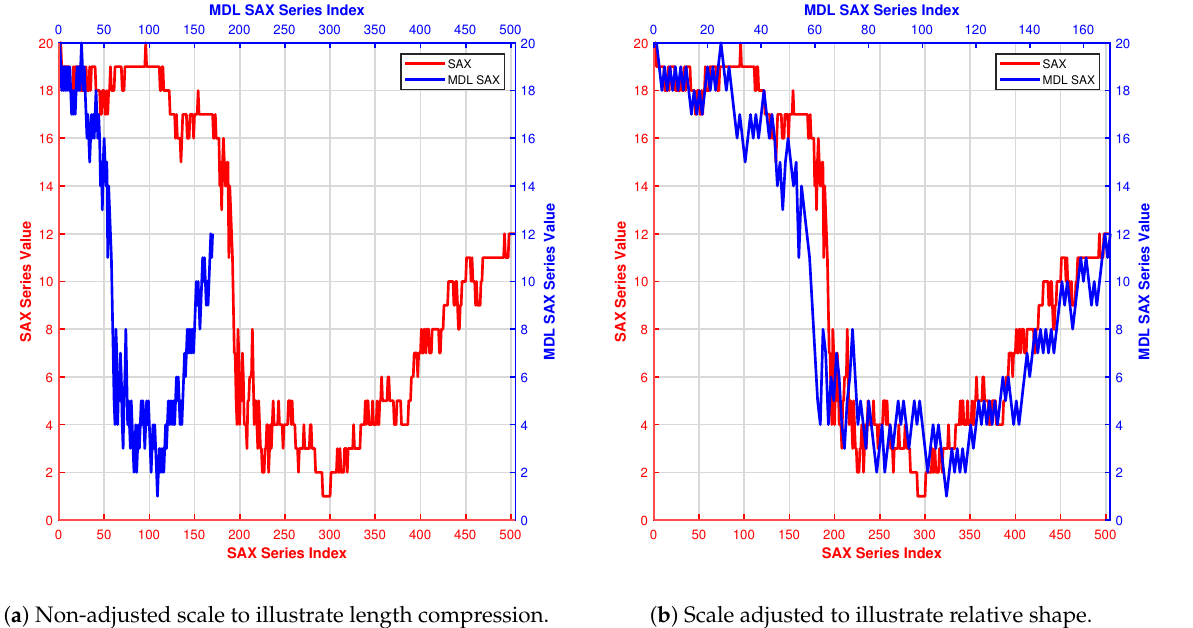
( b ) Scale adjusted to illustrate relative shape. Figure 6. SAX and MDL-SAX representations of the S&P500 from January 2008 to January 2010. SAX alphabet size = 20, Num of SAX segments = series